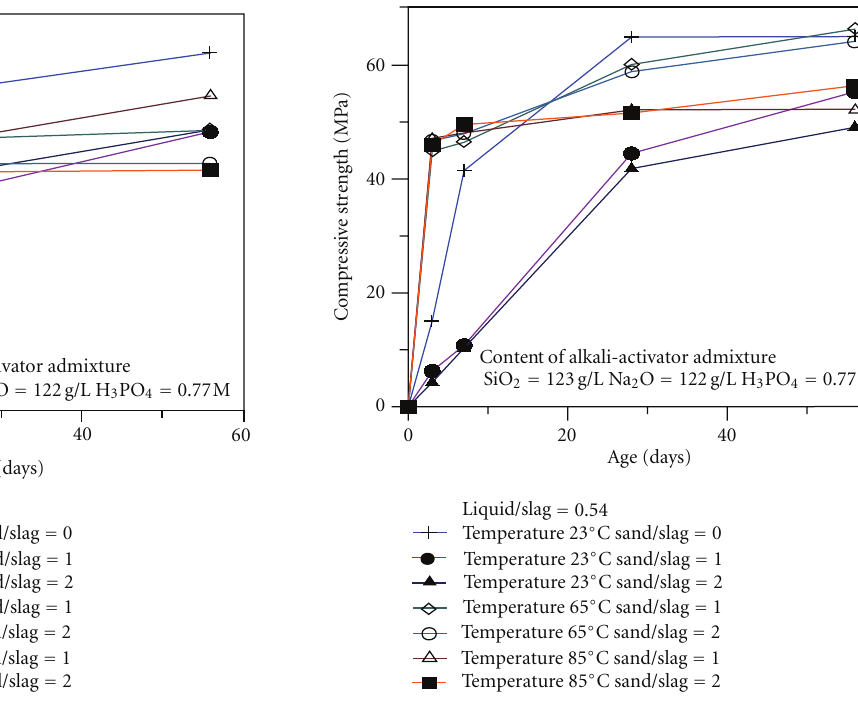
Figure 1: Compressive strength of AAS mortars ( L/S = 0 . 44). Table 2: Compressive strength of Portland cement mortars at wa- ter/cement ratio of 0.54 (MPa).